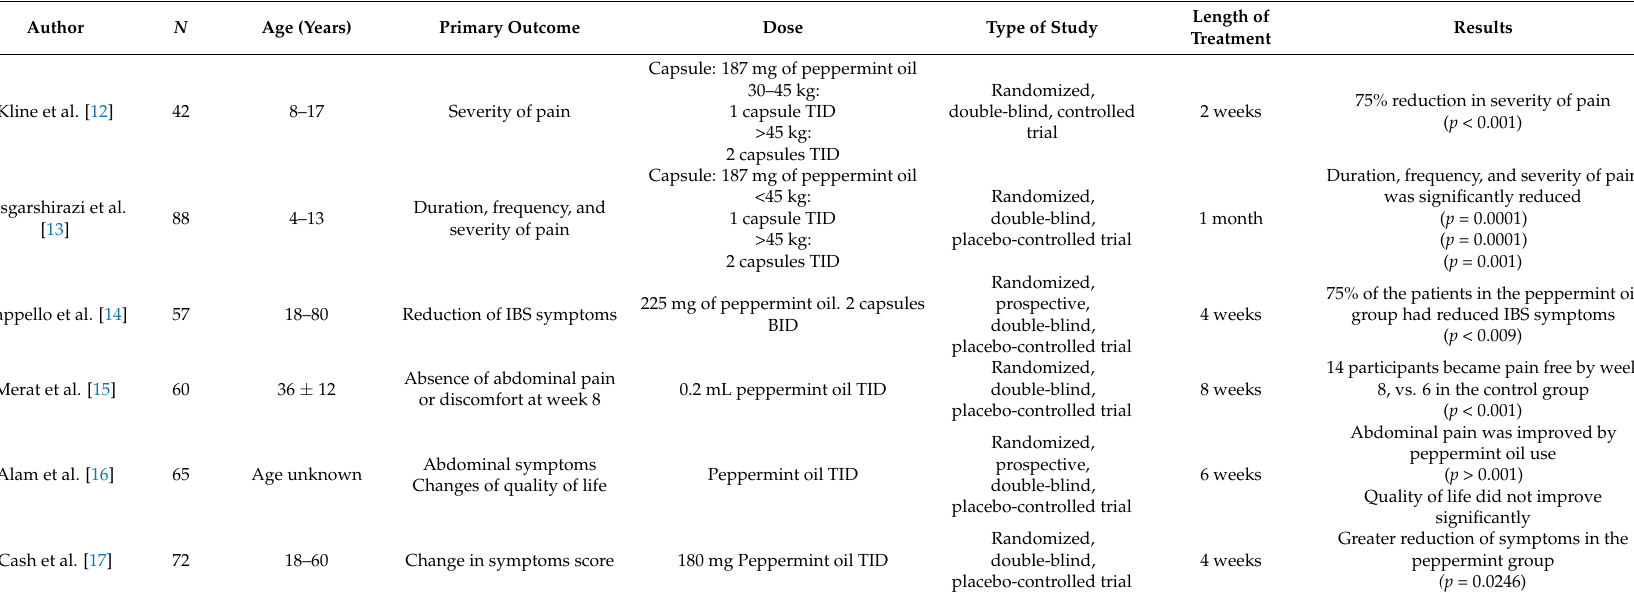
Table 1. Clinical Trials on Peppermint in the treatment of functional gastrointestinal